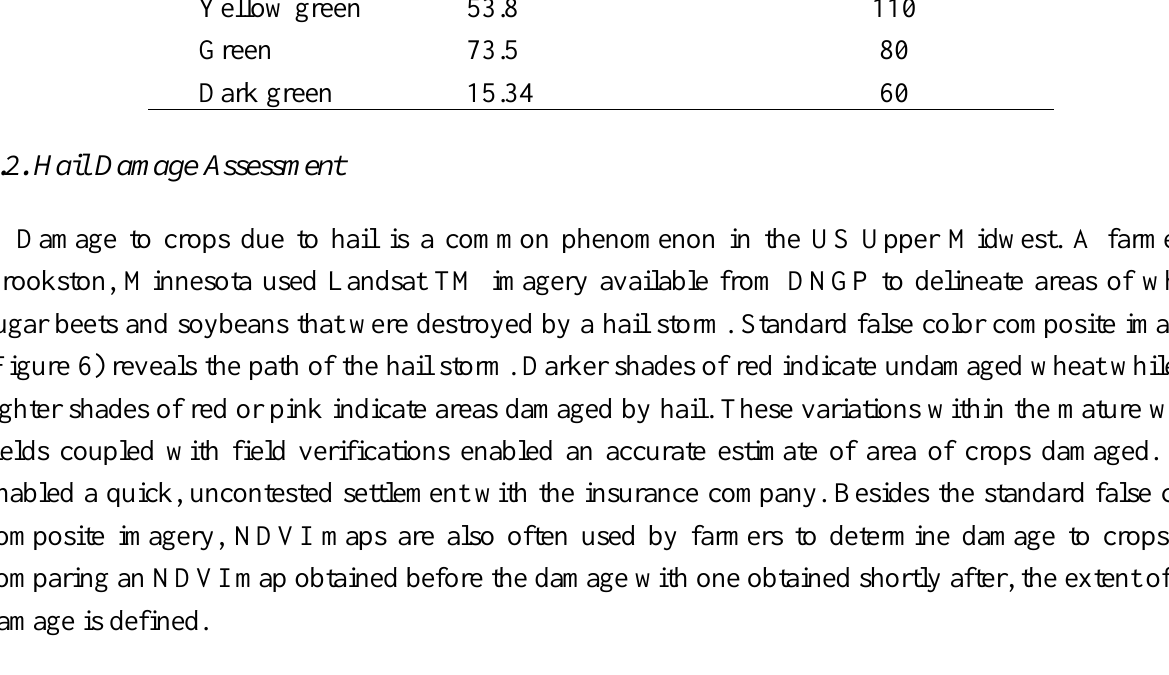
Figure 6. Percentages of crop damage due to hail, determined using standard false color composite imagery (bands 4, 3, and 2) from Landsat TM sensor available through